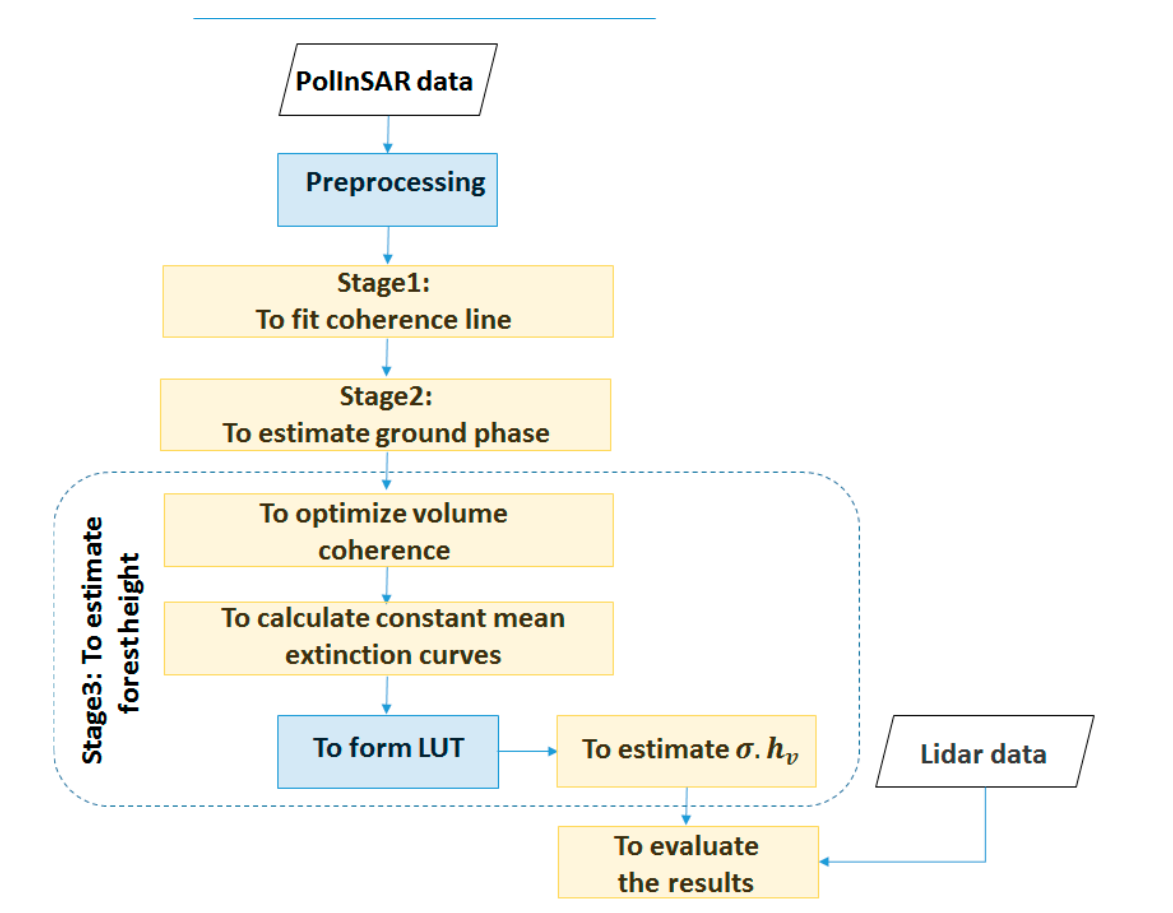
Figure 8. The flowchart of the proposed algorithm for forest height estimation based on the dual PolInSAR data.